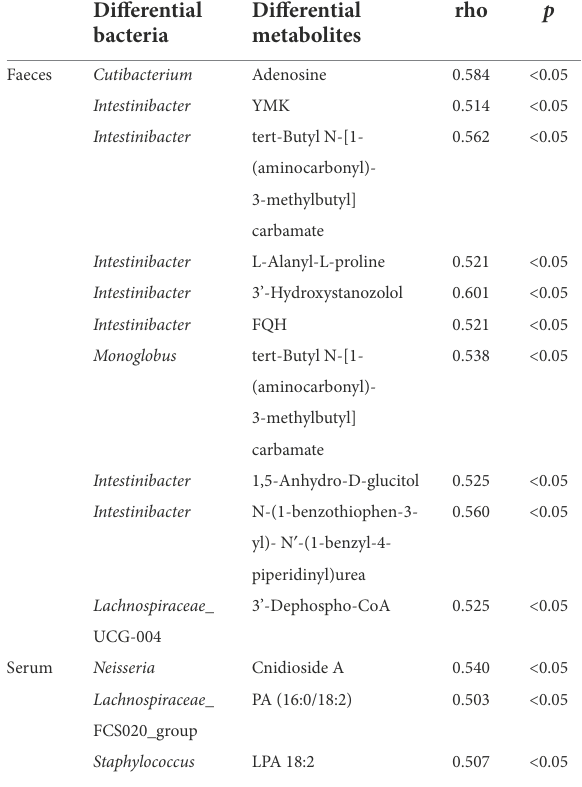
TABLE 2 Correlation analysis results of fecal differential bacteria and differential metabolites (feces and serum). Differential